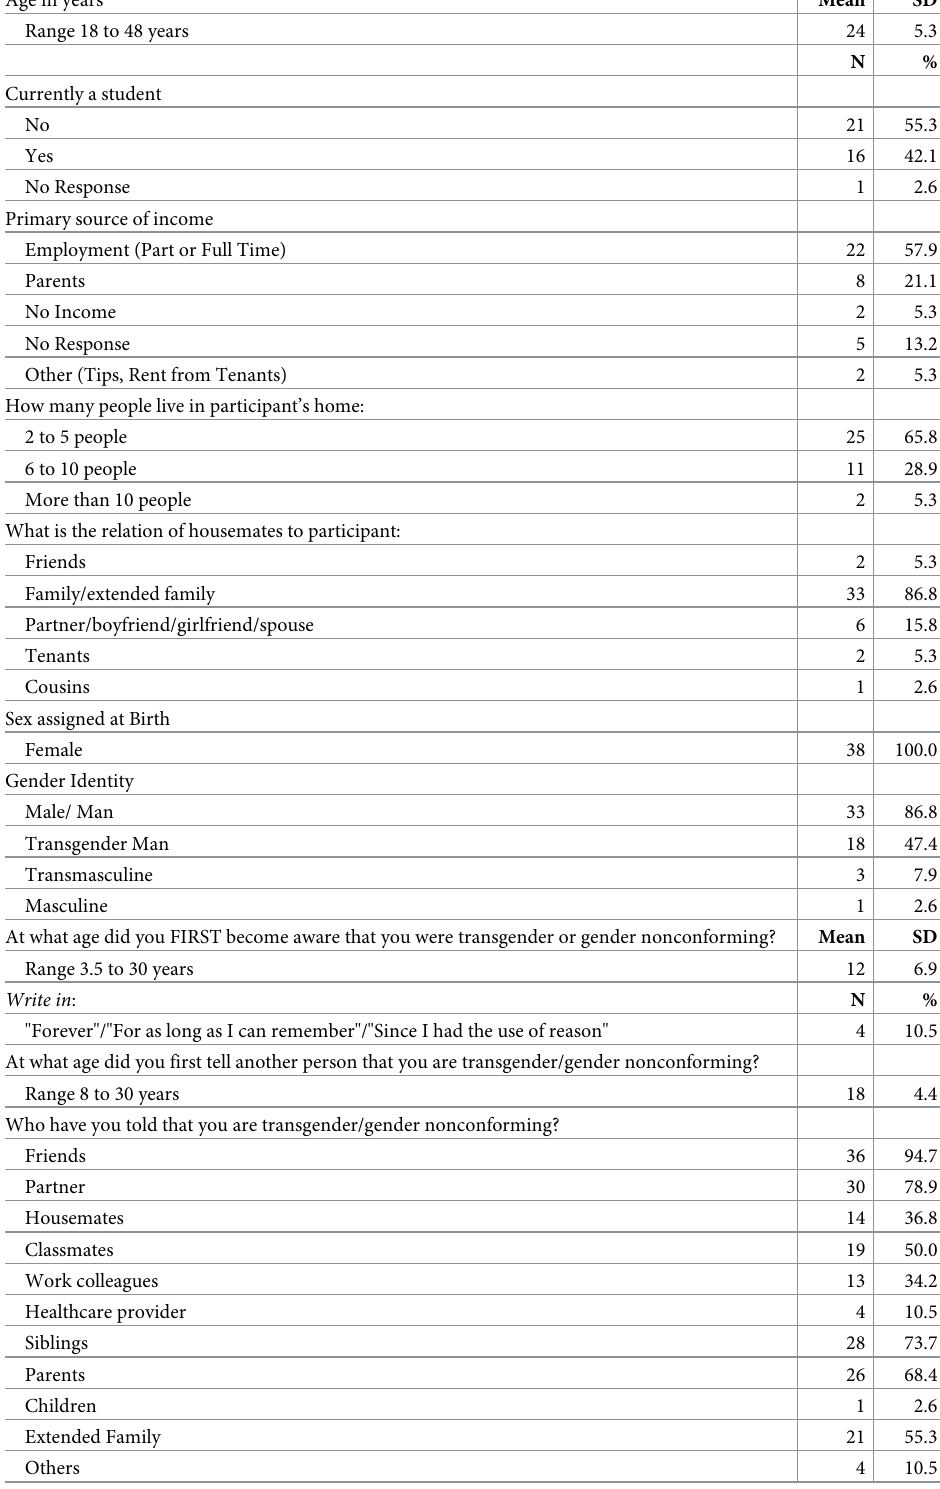
Table 1. Characteristics of the study sample of trans men in Lima, Peru (n =